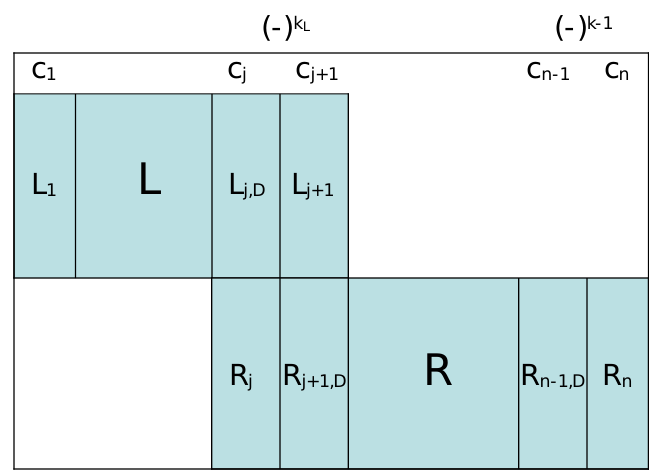
Figure 2 . Matrix version of tree BCFW recursion